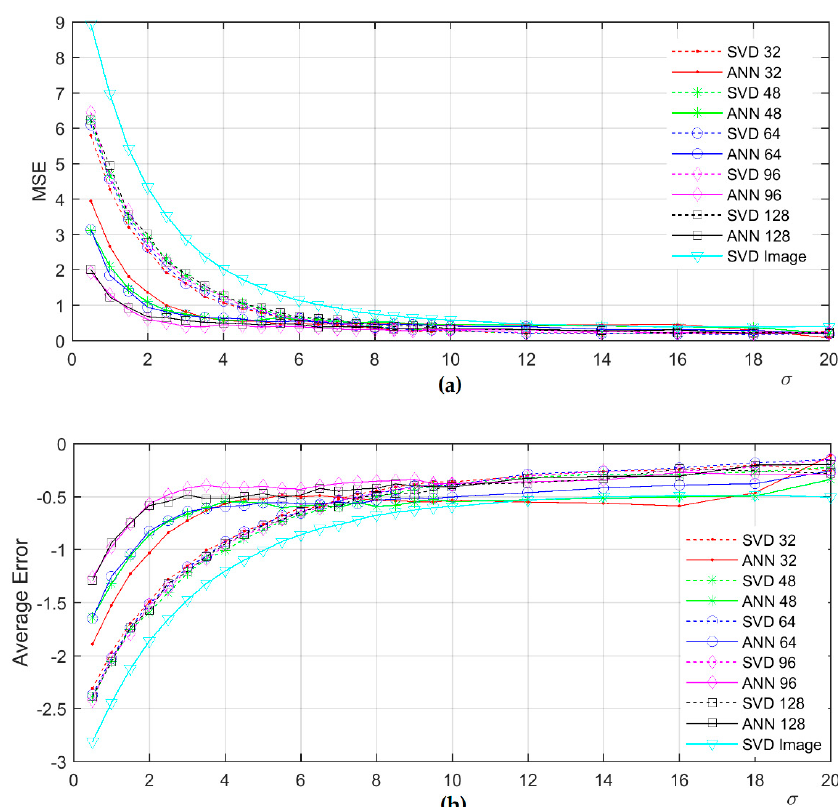
Figure 5. A comparative analysis of the noise level estimation algorithms in terms of ( a ) the mean square error across noise levels and ( b ) the average error across noise levels.